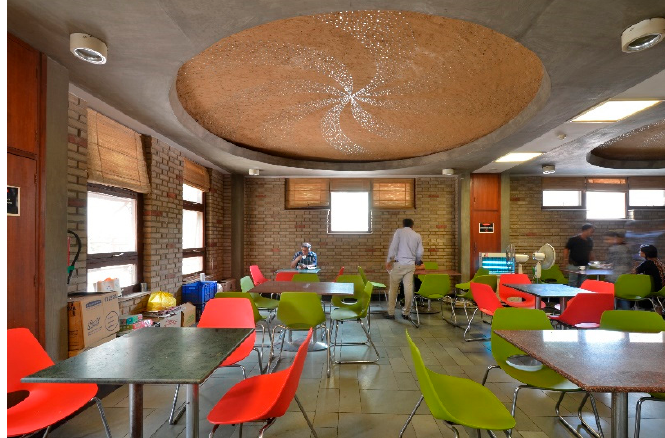
Figure 24. Shallow domed ceilings span the interior spaces of the DA building (Photo: Author).